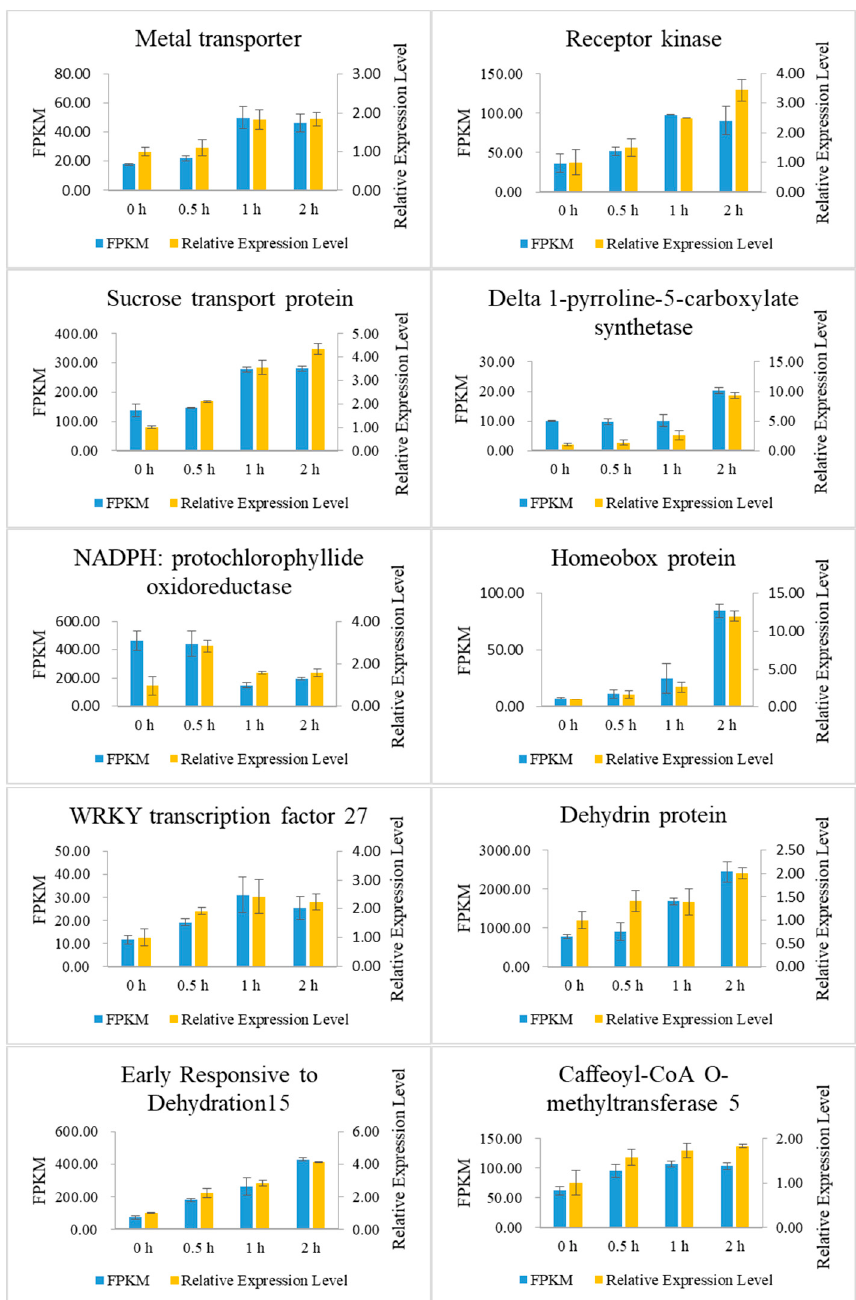
Figure 7. Quantitative real-time PCR analysis of differentially expressed genes.